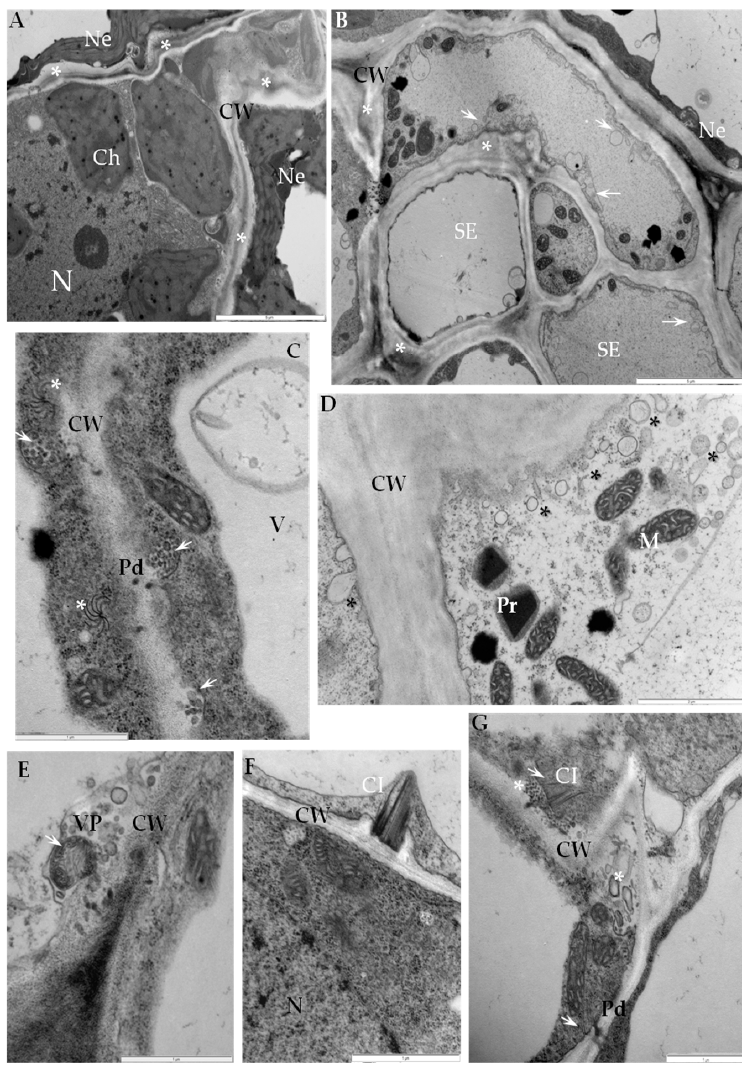
Figure 1. Ultrastructure changes in cell wall area from potato Irys–PVY NTN interaction. ( A ) Cell wall loosening and folding (*) between necrotized and non-necrotized mesophyll cells. Bar 5 µm. ( B ) Cell wall thickening (*) with paramural bodies (arrows) in phloem cells. Bar 5 µm. ( C ) Paramural bodies (arrow) connected with plasmodesmata in association with virus cytoplasmic inclusions (*). Bar 1 µm. ( D ) Cell wall thickening with intense vesicles distribution (*). Bar 2 µm. ( E ) PVY particles (arrow) in vesicle derived from cell wall with other paramural bodies in the vicinity of changed cell wall. Bar 1 µm. ( F ) PVY inclusions in associated with highly changed cell wall in mesophyll cell. Bar 1 µm. ( G ) PVY inclusions (arrow) associated with plasma membranes and intense distribution of paramural bodies (asterisk) along the deformed cell wall. Bar 1 µm. Ch—chloroplast, CI—cytoplasmic inclusions, CW—cell wall, ER—endoplasmic reticulum, N—nucleus, Ne—necrosis, Pd—plasmodesmata, SE—sieve element, V—vacuole, VP—virus